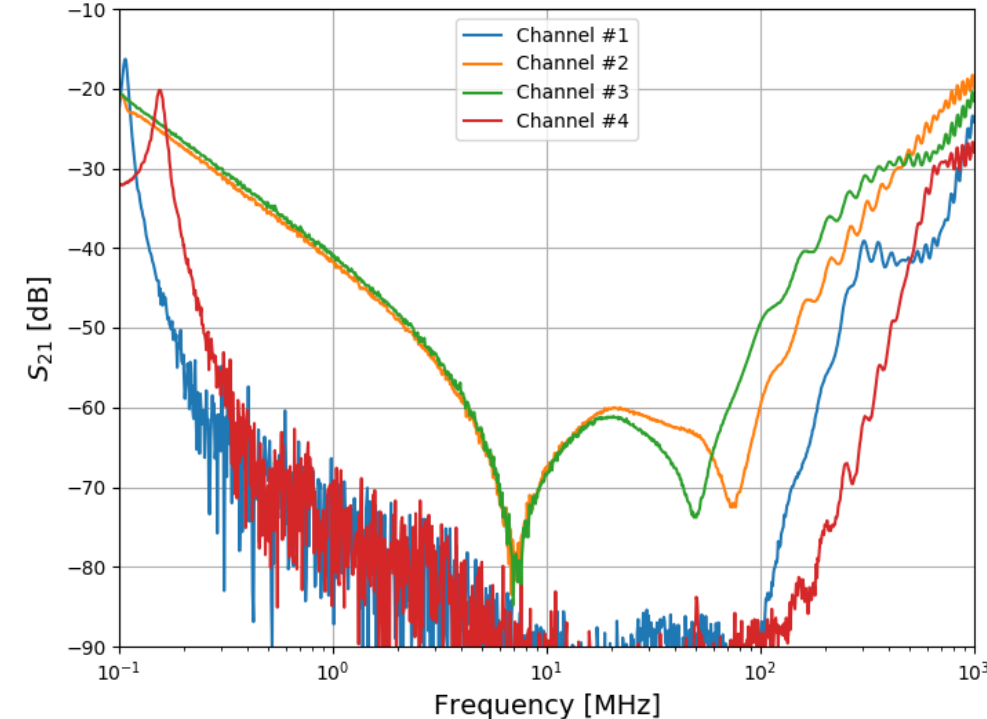
Figure 6. IL measurements on Test Board @ VNA (50 Ω in; 50 Ω